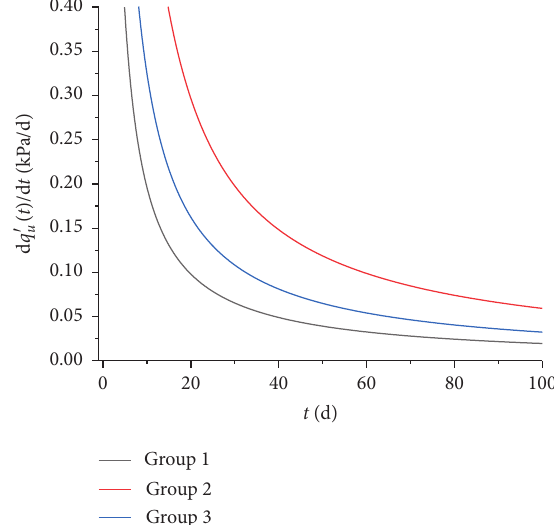
Figure 6: The relation curve of thixotropic strength recovery rate and curing